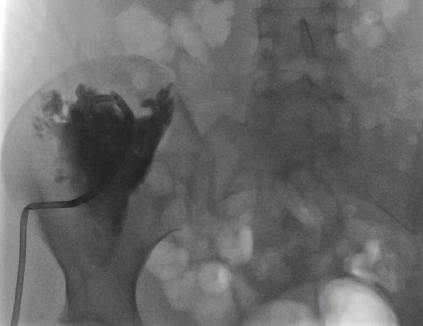
Figure 4: Abscessogram of the sterile seroma involving the right iliacus muscle, after drainage of septic